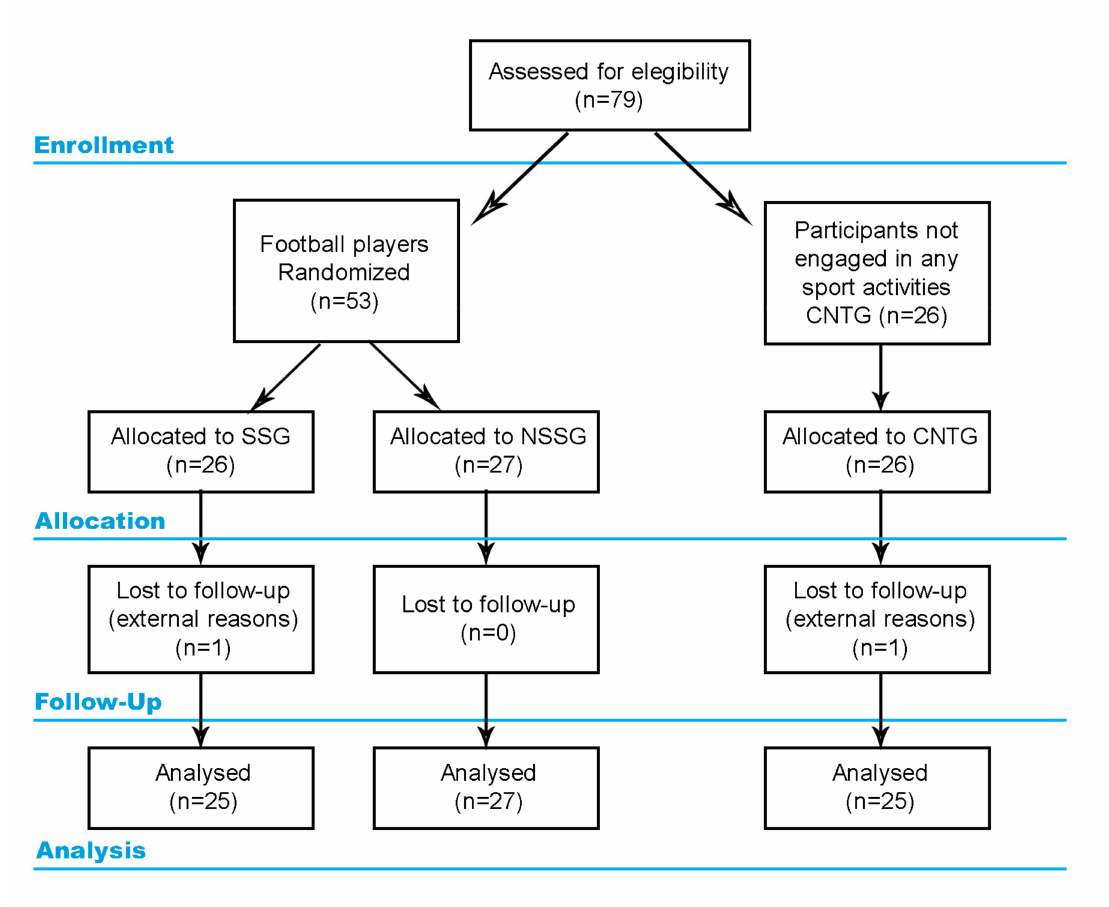
Figure 1. Graphical representation of the study design. NSSG = non-sport-specific group, SSG = sport-specific